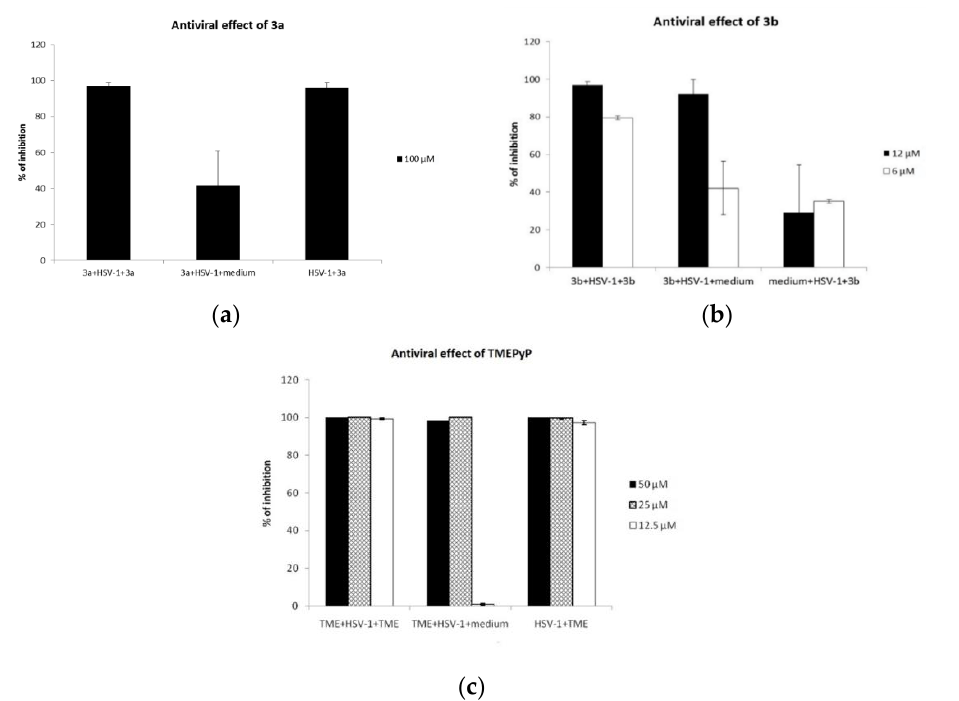
Figure 7. Inhibitory effect of porphyrins on the HSV-1 replication. The Vero cells were treated with compounds 3a (100 µM) ( a ), 3b (12 µM and 6 µM) ( b ) and TMePyP (50 µM, 25 µM and 12.5 µM) ( c ) simultaneously with HSV-1 (MI 0.1) or after HSV-1 (MI 0.1) adsorption. The results are presented as the percentage of the virus titer with porphyrin relative to its titer in the control (without porphyrin), which was taken as 100%. Each bar represents the mean ± deviation. Three experiments were performed with four repetitions.